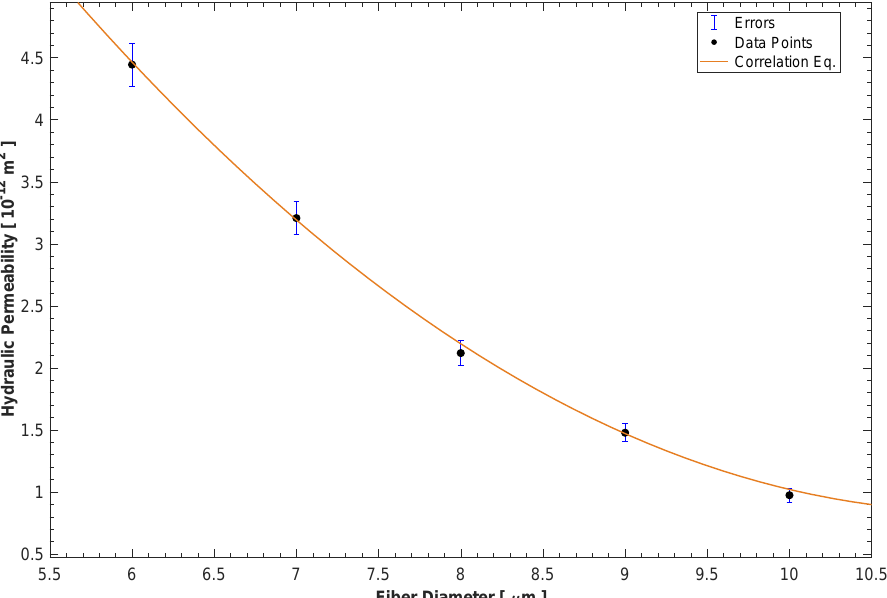
Figure 5. Computed hydraulic permeability of the GDL as a function of the fiber diameter. The proposed correlation (a polynomial function) presents a good fit for the data.